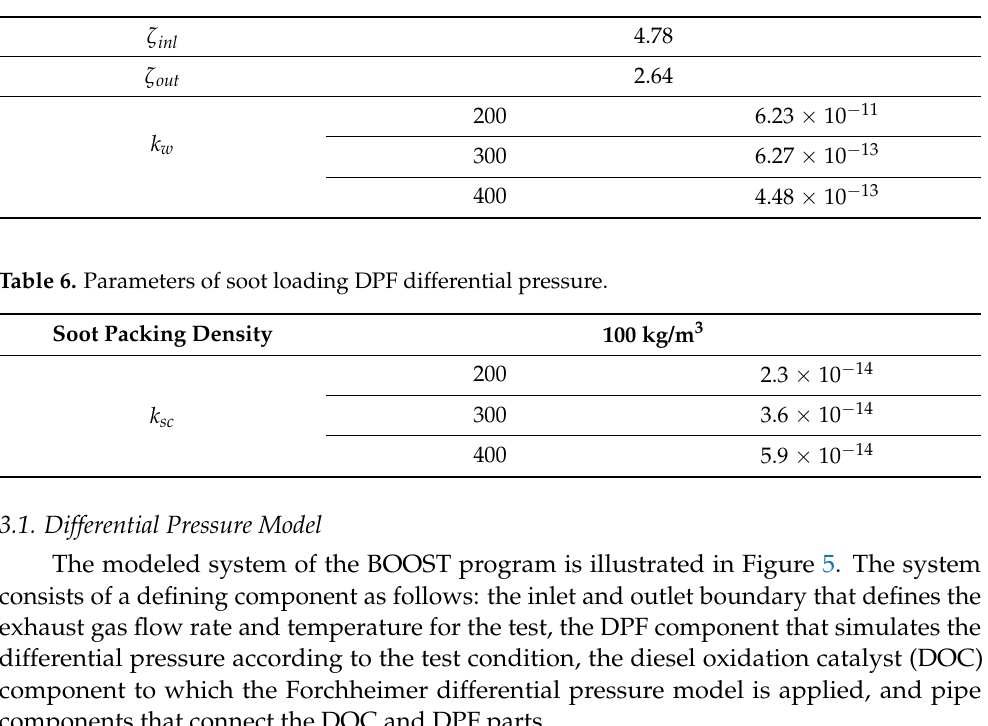
Table 5. Parameters of differential pressure for clean DPF.